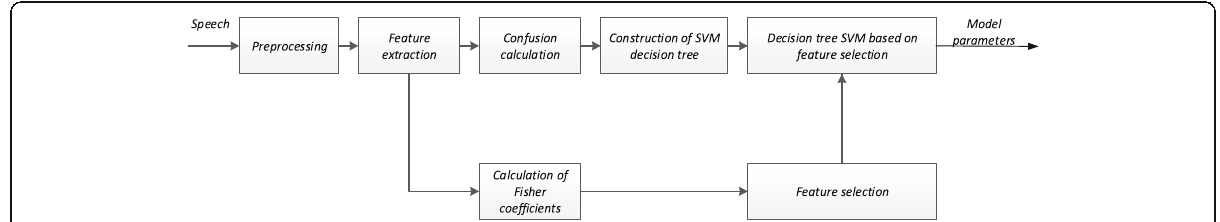
Fig. 1 Construction flow chart of decision tree SVM with feature